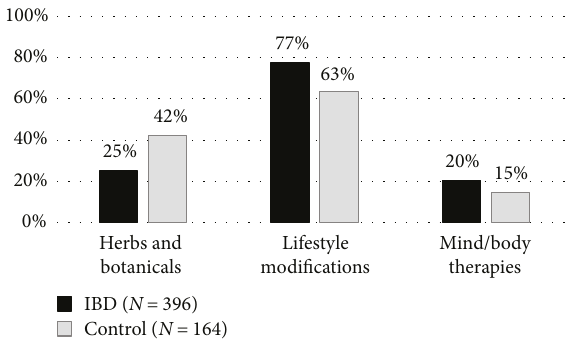
Figure 2: Frequency of CAM use in the IBD and control group. CAM: complementary and alternative medicine; IBD: in fl ammatory bowel